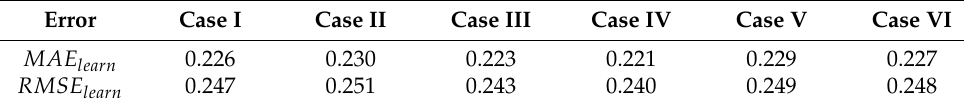
Table 10. The slopes of the straight-line fit of the error metrics.